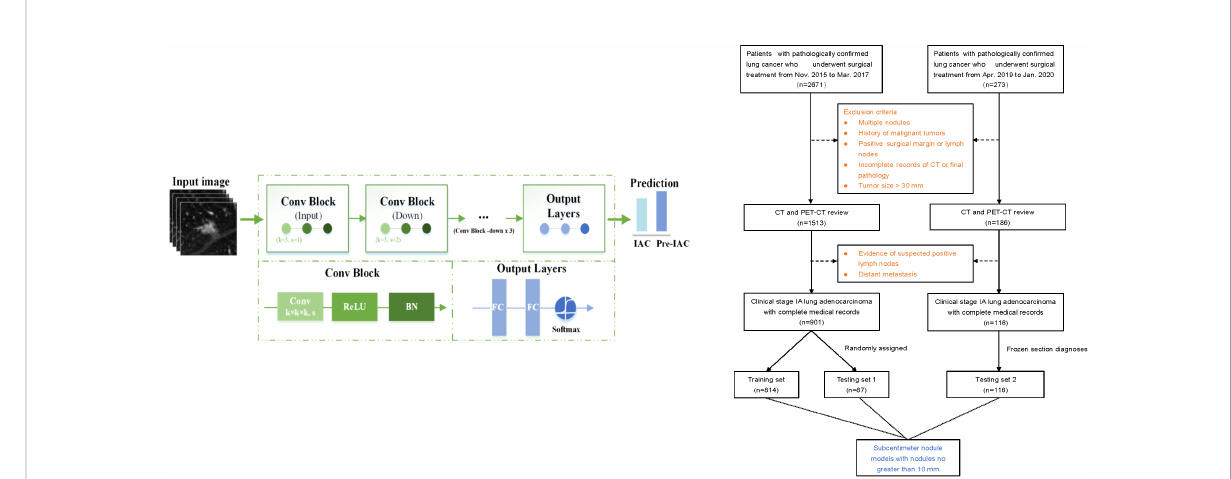
FIGURE 1 The fl ow chart of patient selection and deep learning architecture. “ Conv ” represents a convolution, “ k ” represents the kernel, and “ s ” denotes the number of strides. “ BN ” represents the batch normalization layer. “ FC ” represents a fully connected